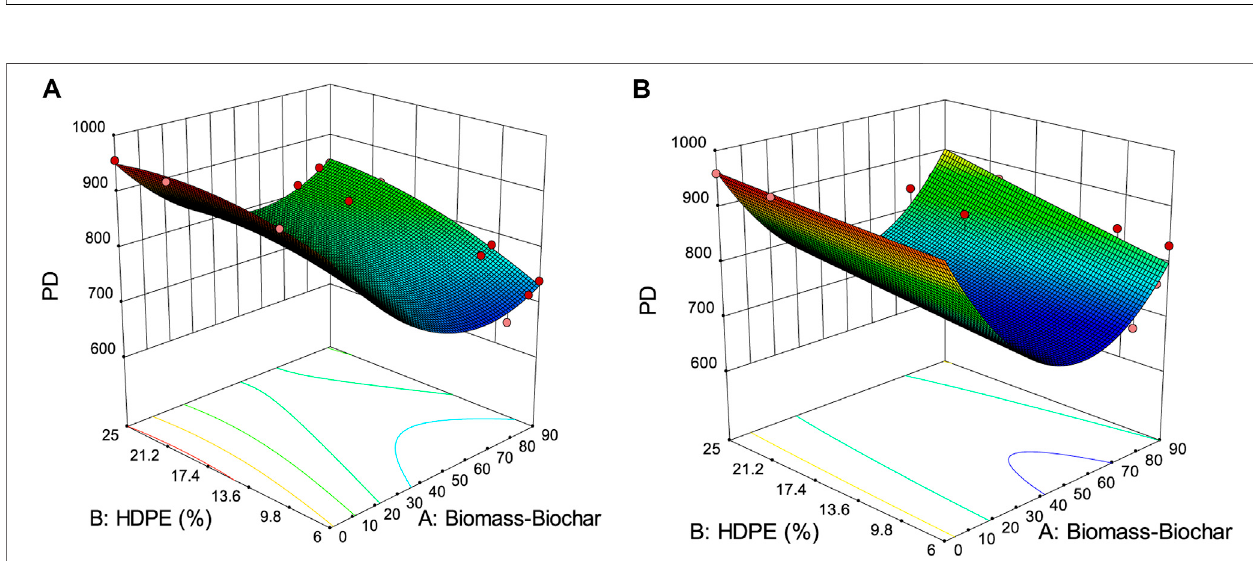
FIGURE 5 | Effect of 3D dimensional response surface plots for (A) wheat and (B) barley straw-biochar pellets for pellet density (PD).